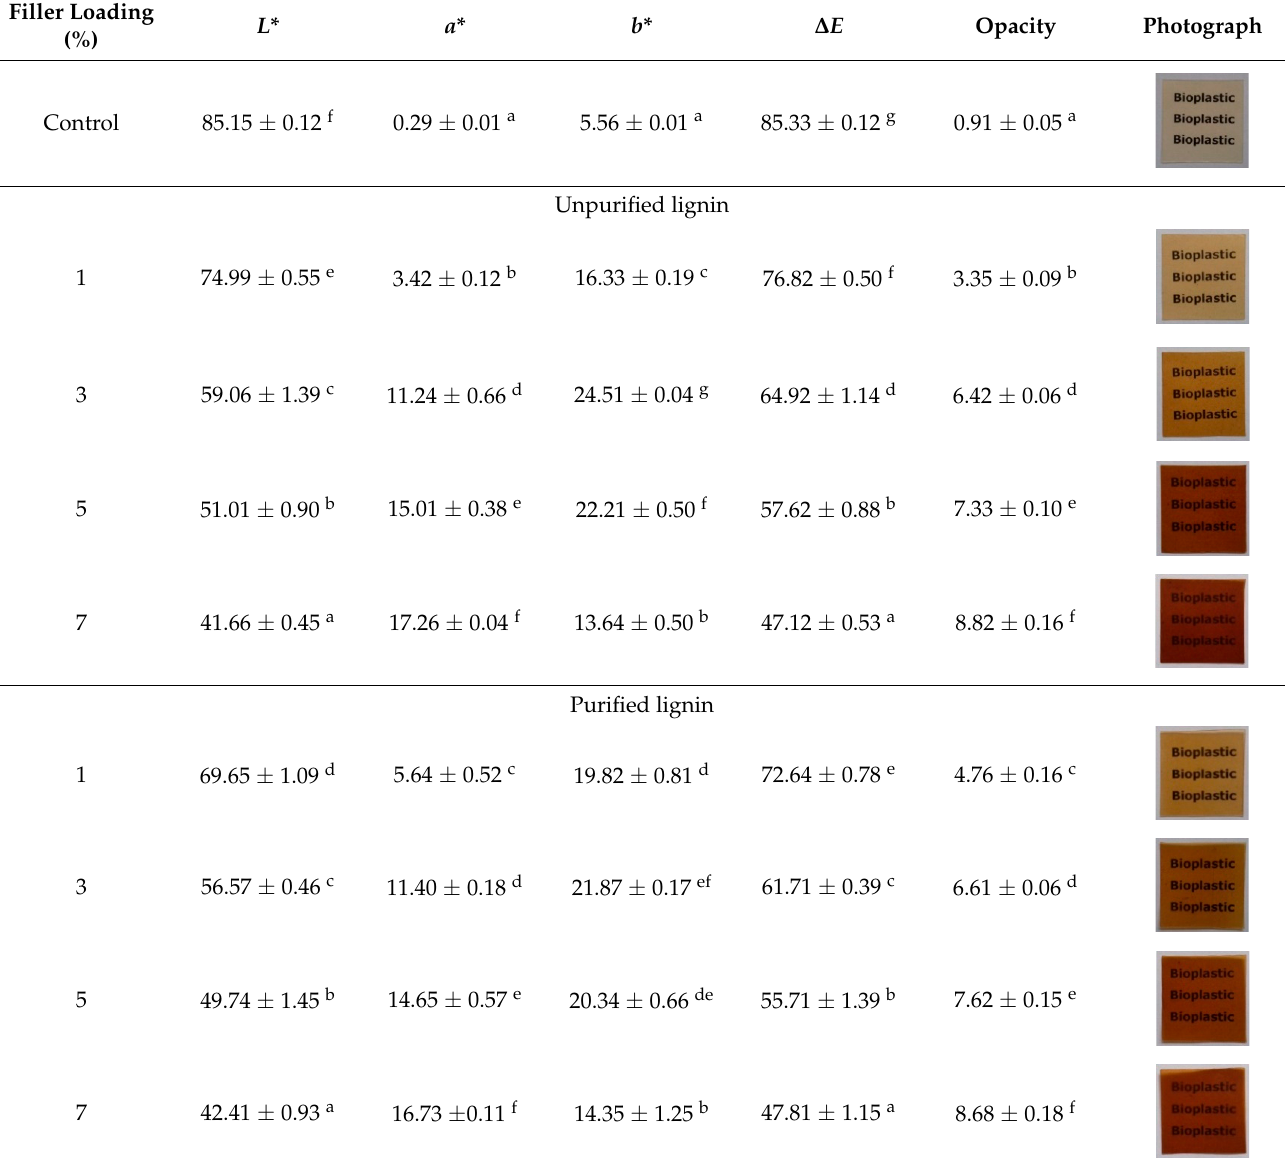
Table 2. Colour and opacity of macroalgae-based biopolymer film reinforced with unpurified and purified LNPs. Filler Loading Photograph Opacity